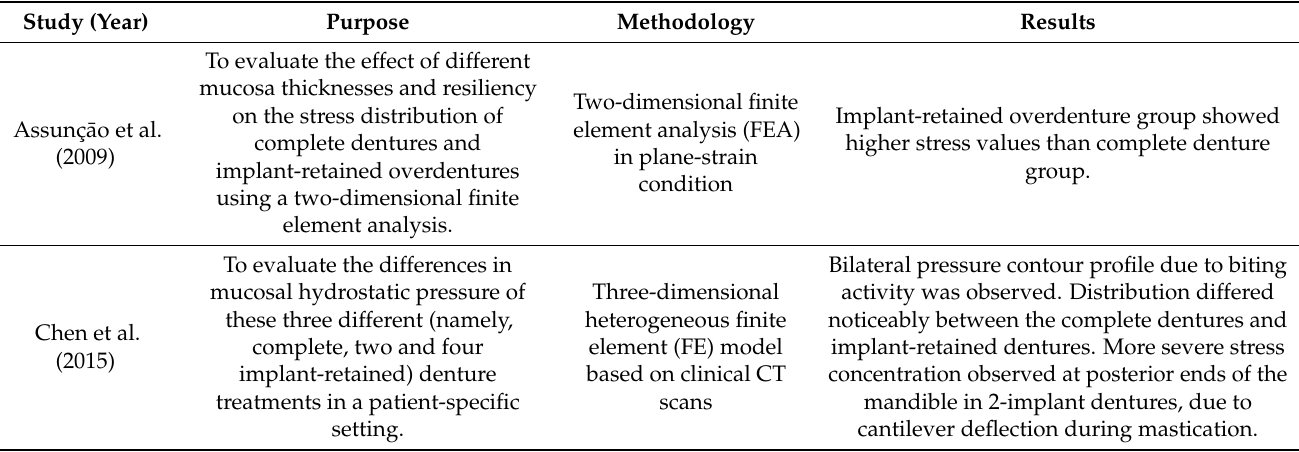
Table 4. In vitro and/or in silico studies investigating the pressures developed beneath